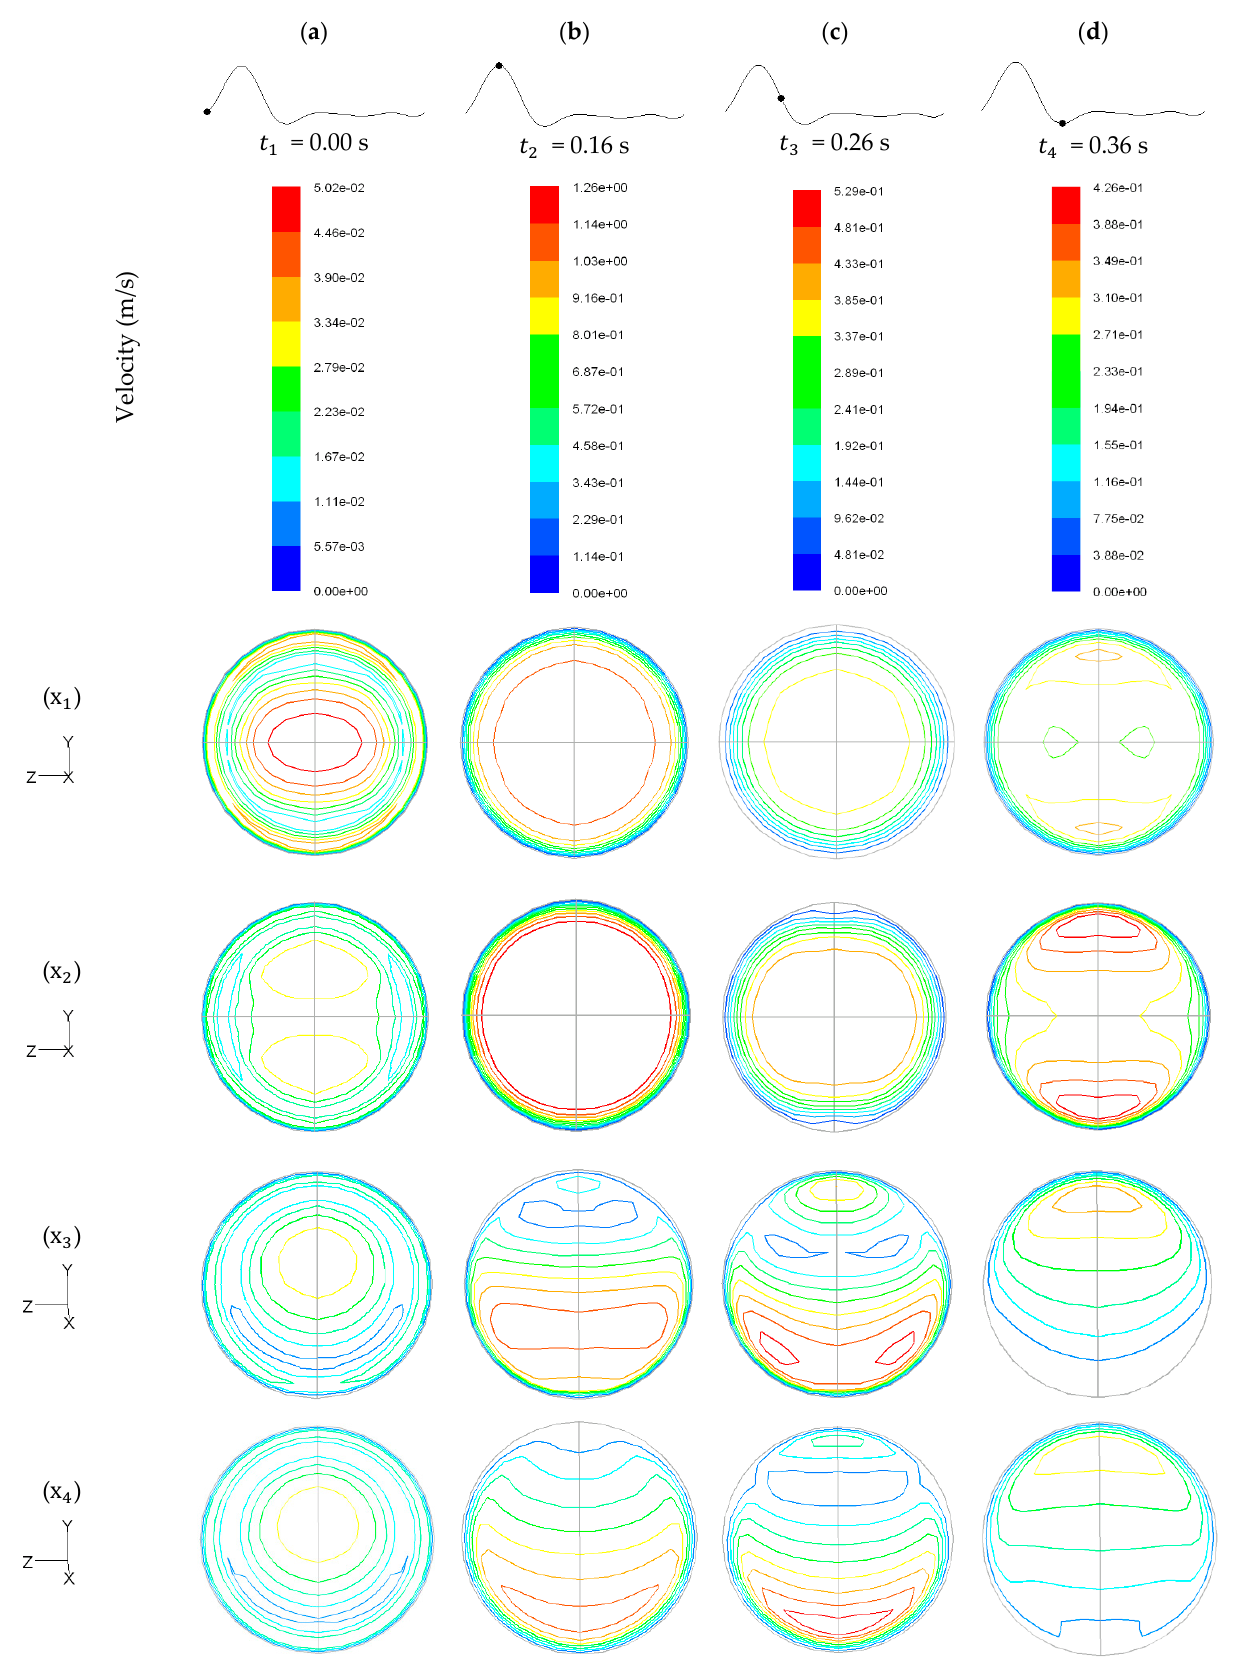
Figure 8. Distribution of velocity magnitude (m/s) in the cross-sections in the vicinity of iliac bifurcation along the cardiac cycle, ( a ) t = 0.00 s, ( b ) t = 0.16 s, ( c ) t = 0.26 s, ( d ) t = 0.36 s.